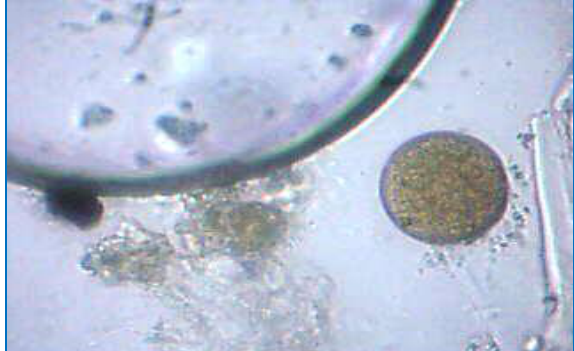
Figure, c: Toxocara canis egg in stray dogs.